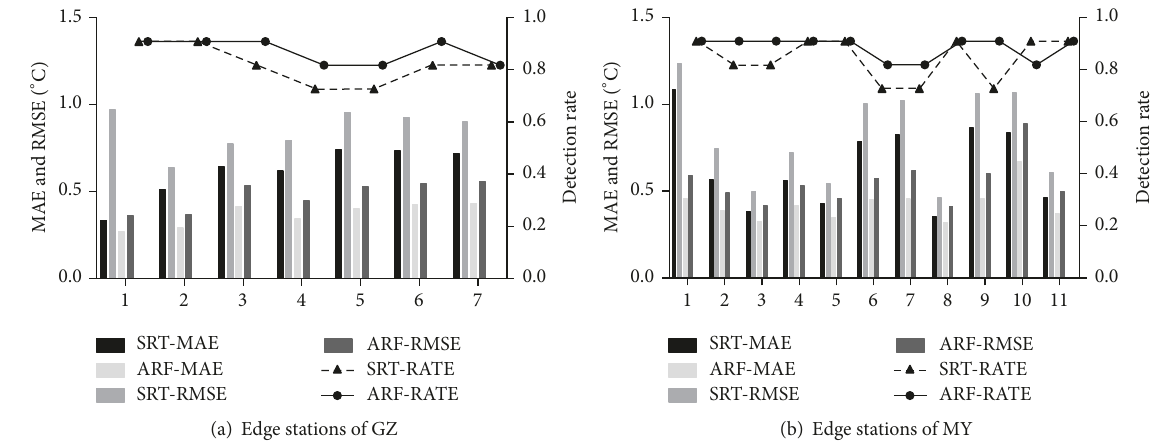
Figure 12: Comparisons of performance between the ARF and SRT methods for different edge stations: (a) Guangzhou and (b)